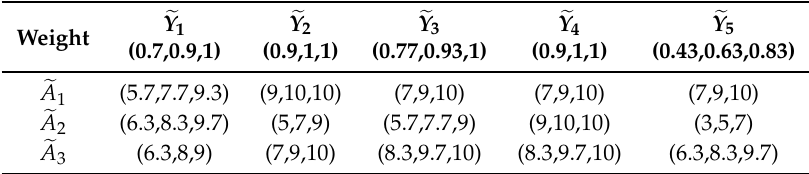
Table 5. The fuzzy decision matrix for the personnel selection